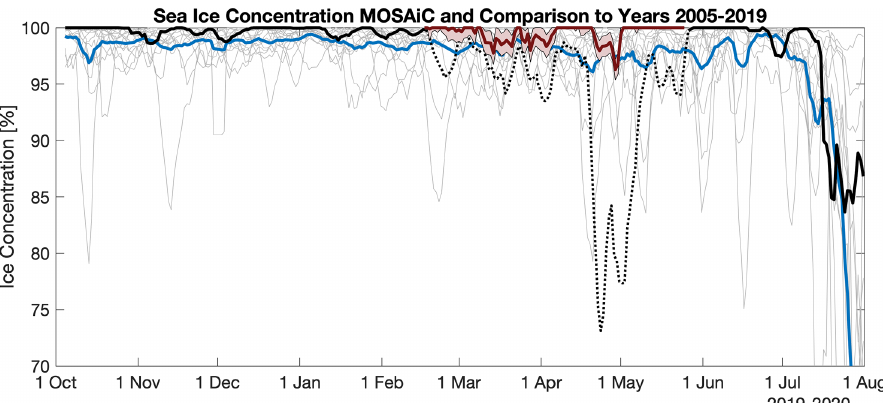
Figure 9. Sea ice concentration within a 3km radius around the CO (6.25km grid cell; black) along the MOSAiC drift from 4 October 2019 to 31 July 2020 in comparison to the ice concentrations from 2005–2006 to 2018–2019 for the same drift trajectory. The blue line shows the average for 2005–2006 to 2018–2019, while the gray lines show the individual years. All time series are smoothed with a 5d running mean. During spring, warm air intrusions caused a significant temporary reduction in the sea ice concentration (dashed black line). We, therefore, show that with uncertainty estimates, in addition to an alternative sea ice concentration data set during the time (red and shaded red; not available for the climatology; see main text).